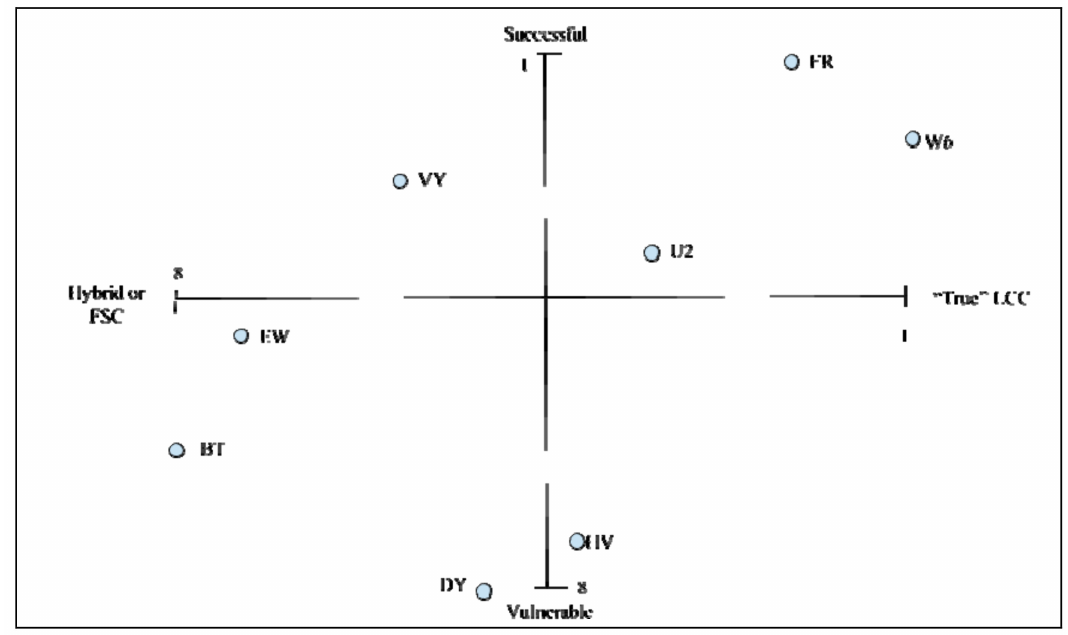
Figure 3. Quadrant diagram results of TOPSIS Source: compiled by the